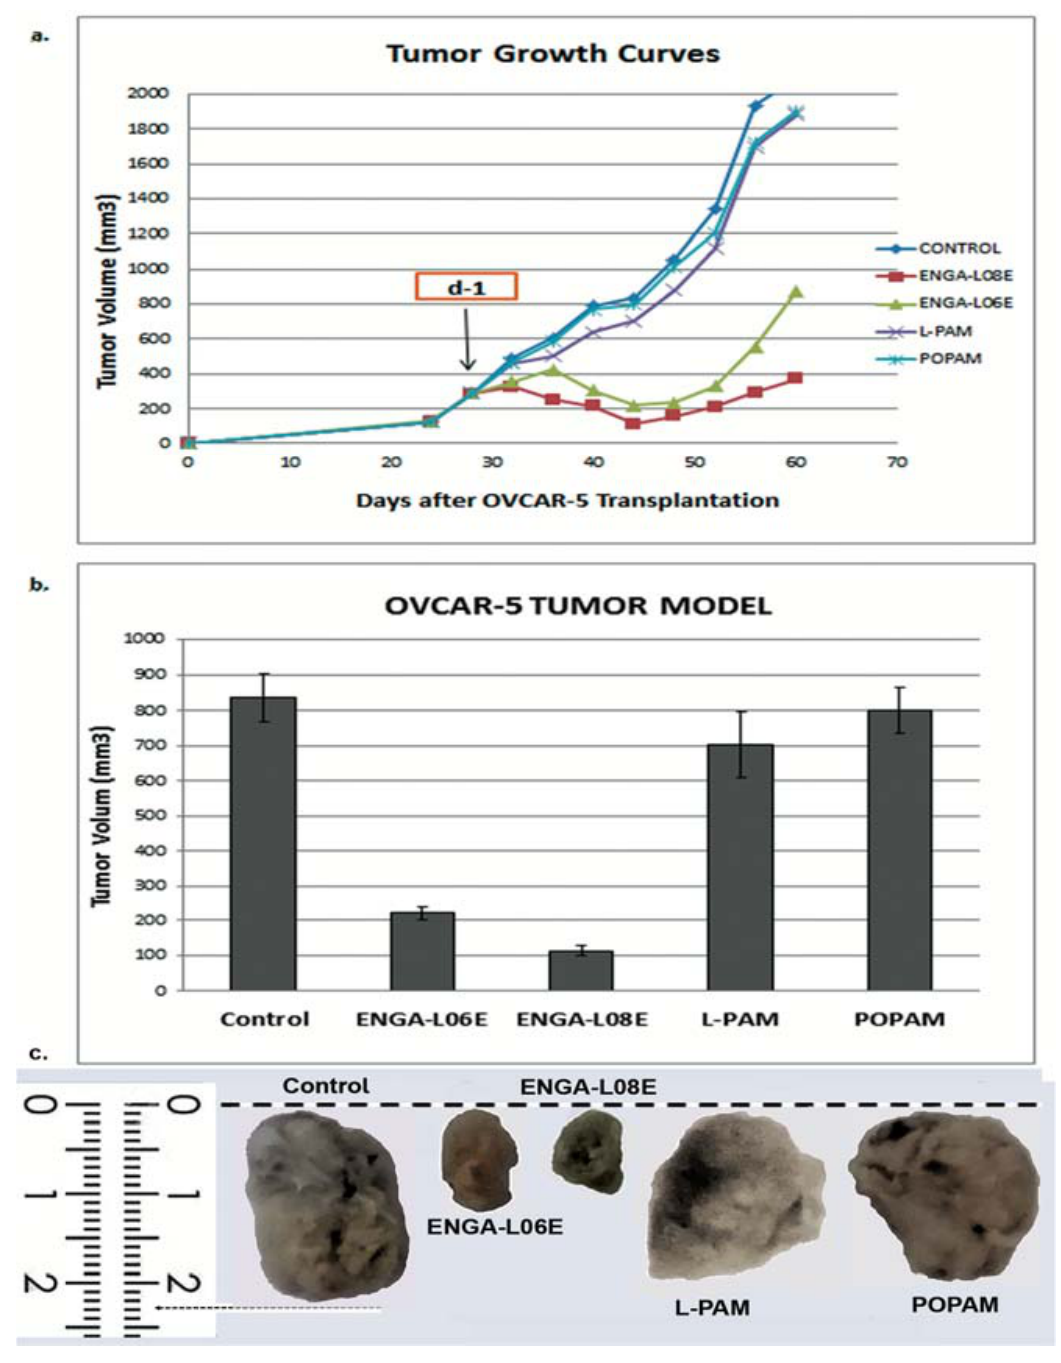
Figure 5. ( a ) In-vivo growth inhibition of OVCAR-5 human ovarian adenocarcinoma induced by Figure 5. ( a ) In ‐ vivo growth inhibition of OVCAR ‐ 5 human ovarian adenocarcinoma induced by ENGA-L06E, ENGA-L08E, L-PAM, and POPAM intraperitoneal administration; ( b ) The tumor volume ENGA ‐ L06E, ENGA ‐ L08E, L ‐ PAM, and POPAM intraperitoneal administration; ( b ) The tumor of the OVCAR-5 adenocarcinoma for all studied compounds, on day 16 after drug administration, when there was the highest decrease in tumor volume (induced by ENGA-L08E); ( c ) Representative tumor images of OVCAR-5 human ovarian cancer xenograft removed from mice 28 days after treatment administration (day 1) of ENGA-L06, ENGA-L08, L-PAM, and POPAM